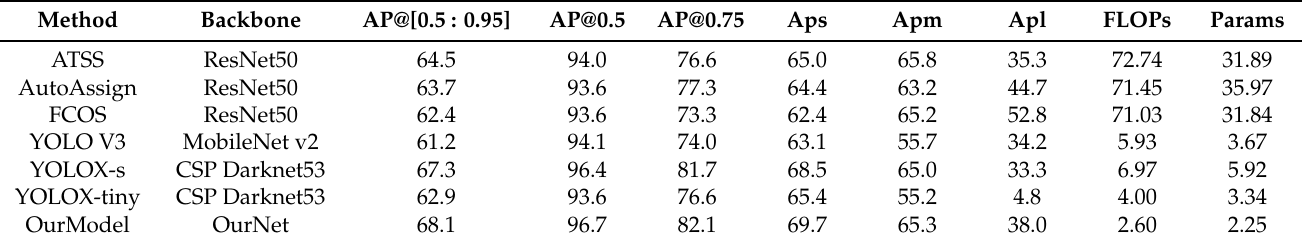
Table 5. Comparison of the performances of different methods on the SSDD.